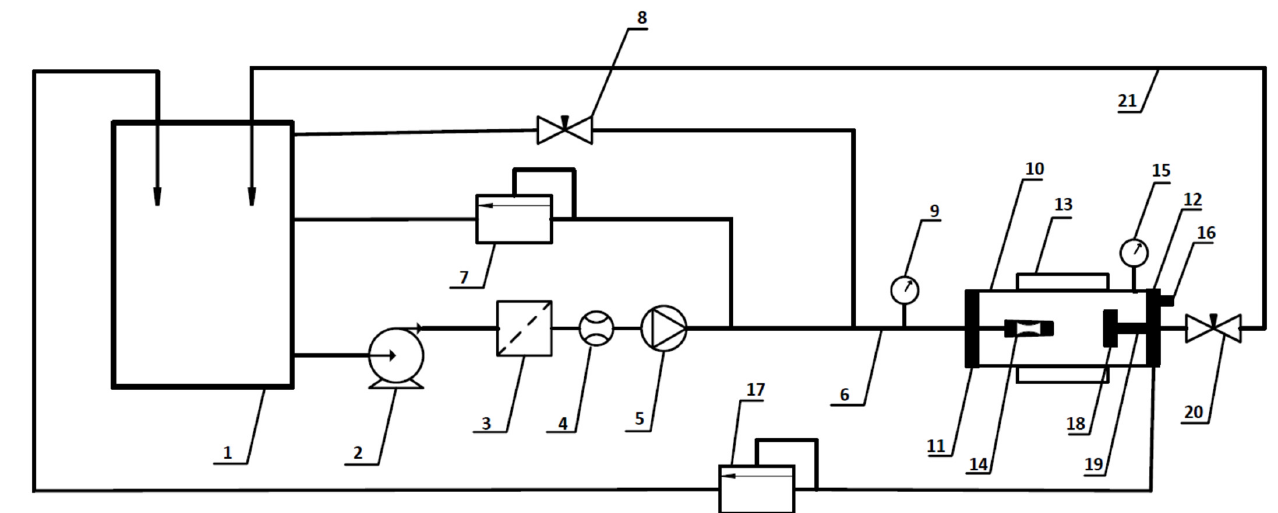
Figure 7. Experimental setup. 1: Water tank; 2: centrifugal booster pump; 3: filter (5 μ m); 4: flowmeter; 5: plunger pump; 6: high-pressure hose; 7,17: safety valves; 8,20: needle valves; 9,15: Bourdon tube pressure gauges; 10: test chamber; 11,12: